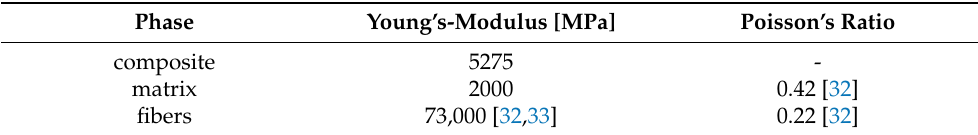
Figure 4. Mechanical characterization of PBT-GF20 and PBT by tensile testing of specimens milled out of injection molded plates. The tensile direction with the PBT-GF20 corresponds to the flow direction of the injection molding process (2-direction). Table 2. Parameters of the isotropic, linear–elastic material model used for the individual phases and parameter of linear elastic fit of the PBT-GF20 composite for comparison.